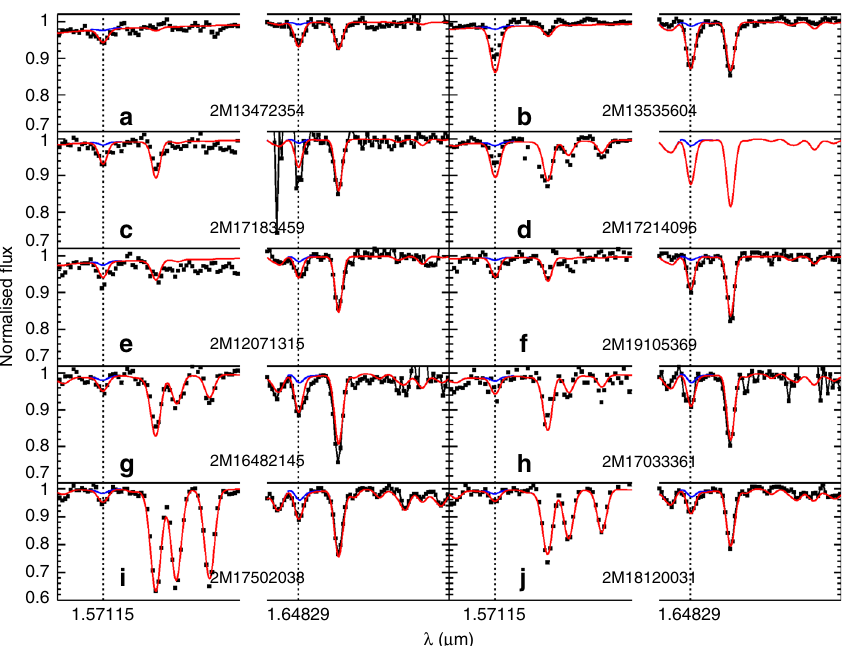
Fig. 3 Spectra of additional P-rich stars in our sample. Observed H-band spectra (in black) of additional (10, a – j ) P-rich stars in our sample around the two P I absorption lines at 1.57115 and 1.6482.9 μ m. A gap in between wavelengths has been introduced to highlight the wavelength discontinuity. The best model spectra (in red) are shown together with model spectra without the P lines (in